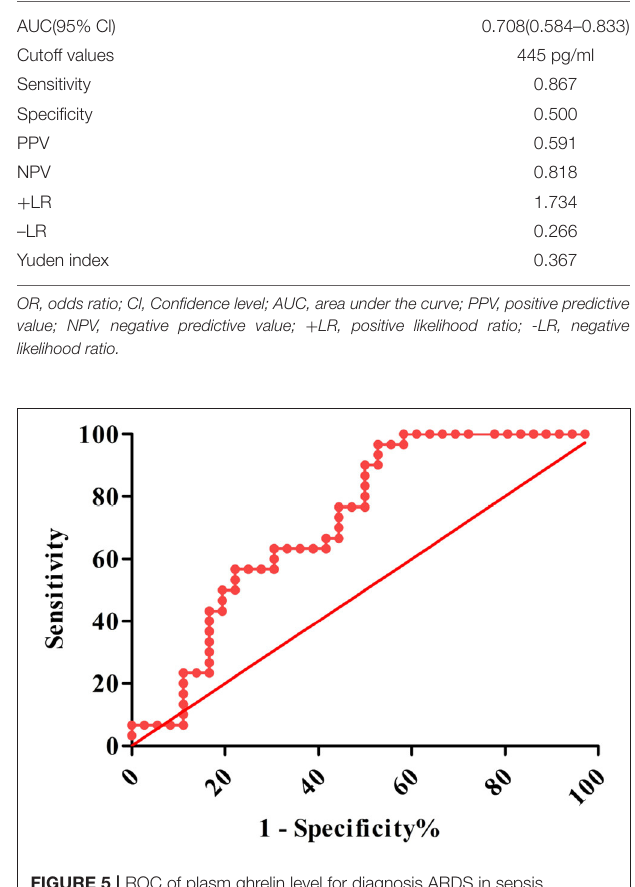
0.178, p = 0.155; r = − 0.122, p = 0.397; r = − 0.101, p =